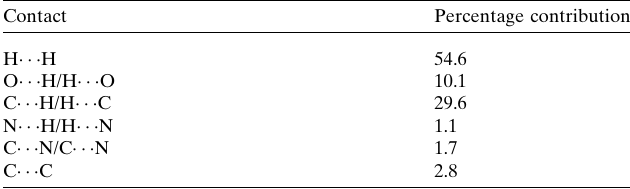
Table 2 Percentage contributions of interatomic contacts to the Hirshfield surface of the title